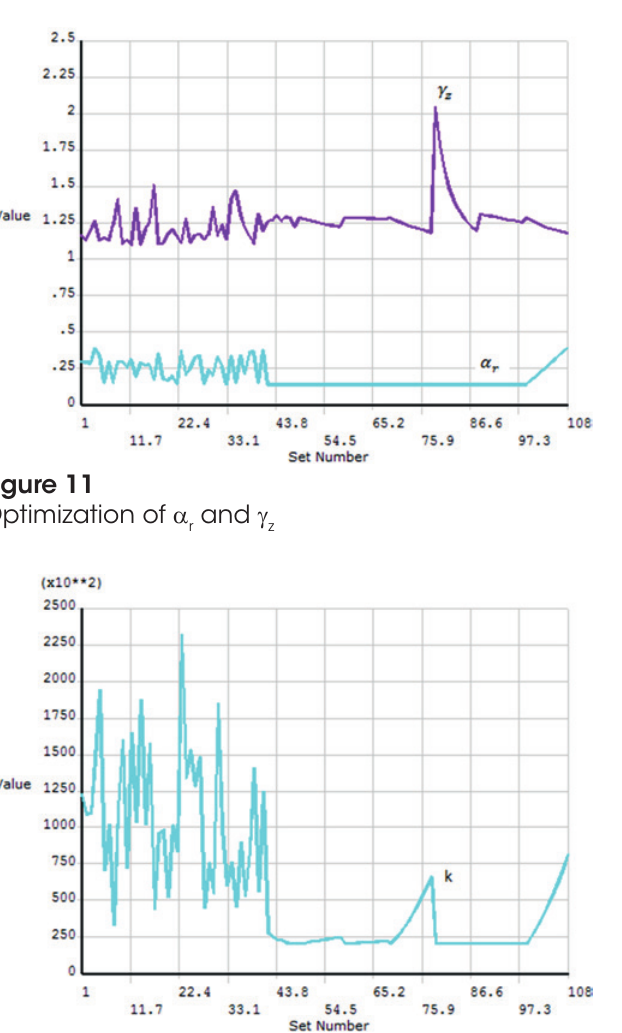
Connection with continuous reinforcement, anchor and support pad, according to Miotto